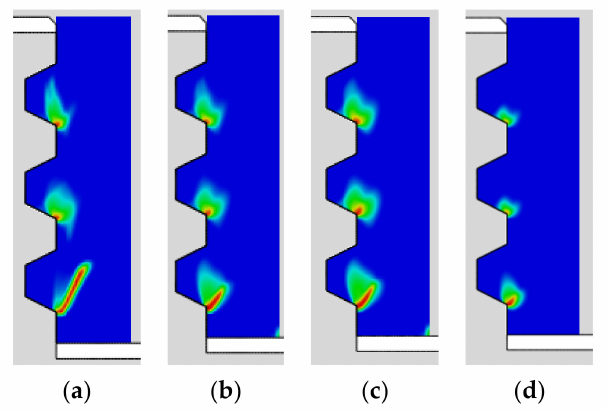
Figure 9. Damage evolution in a 3-keyed joint with σ n = 0.5 MPa: ( a ) V f = 0.0%; ( b ) V f = 0.5%; ( c ) V f = 1.0%; ( d ) V f =